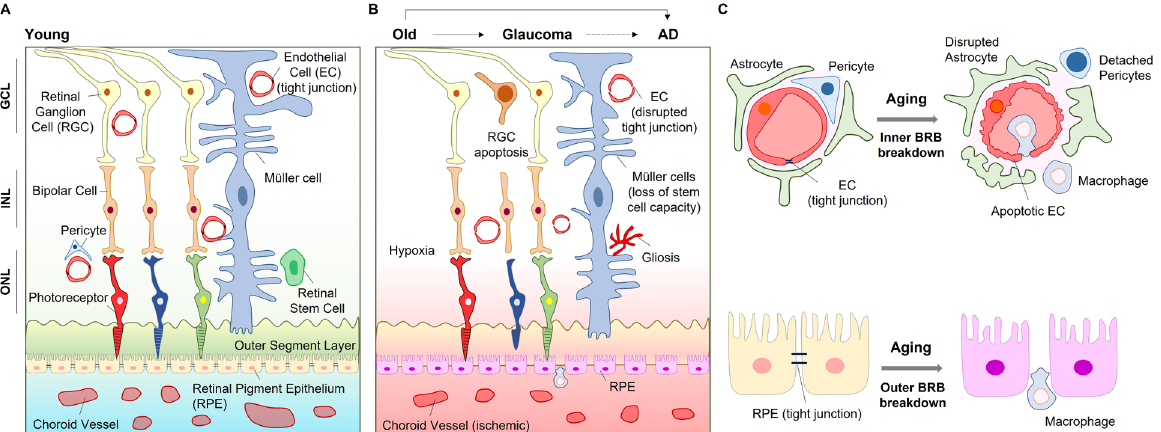
Figure 2. Aging processes in the eye. Young retina shows intact cellular communications for fine vision ( A ); however, aging and consequent age-related eye diseases (i.e., glaucoma, AD) reduce neurovascular cell communication in the eye ( B ). Aging and age-dependent eye diseases show inner BRB breakdown and outer BRB breakdown ( C ). Abbreviation . AD, Alzheimer’s disease; GCL, ganglion cell layer; INL, inner nuclear layer; ONL, outer nuclear layer.